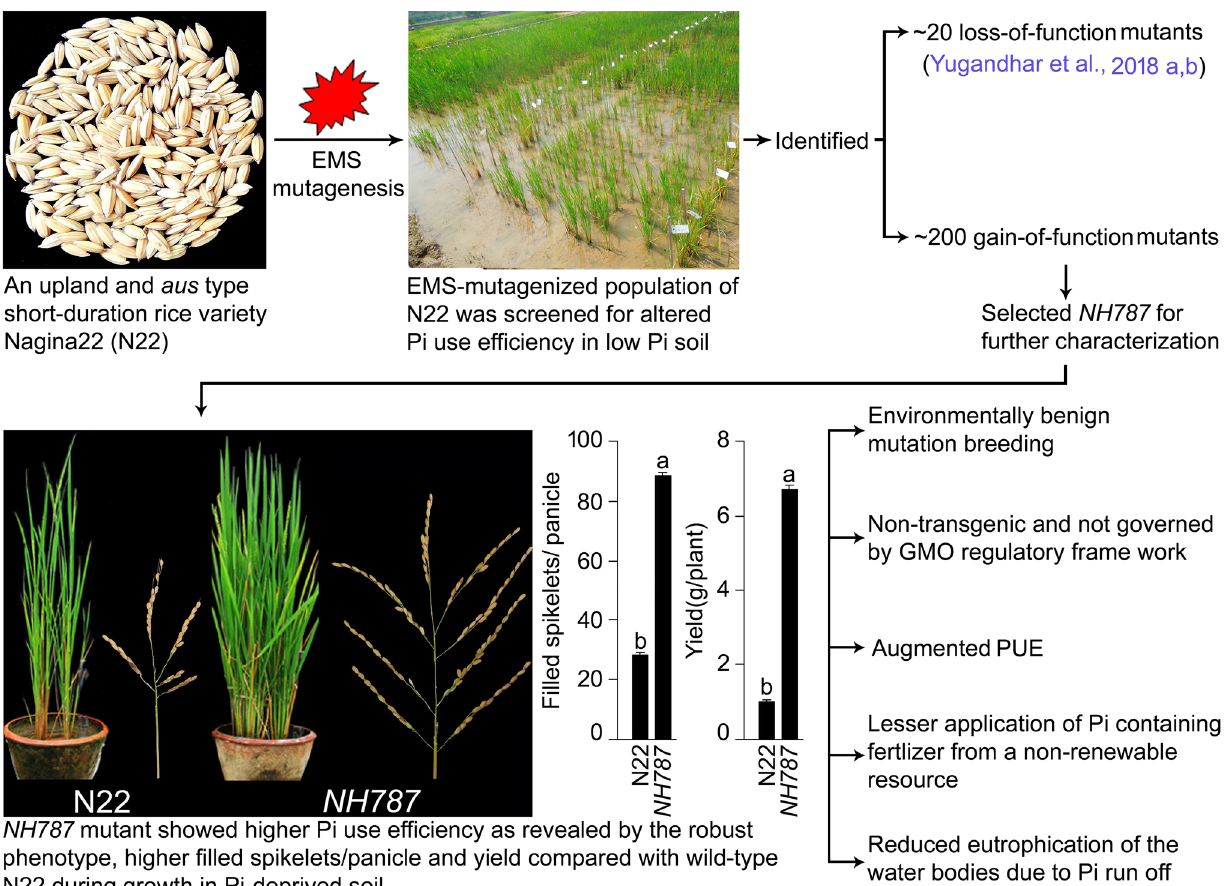
Figure 10. A schematic representation highlighting the efficacy of the EMS mutants for screening the rice variety NH787 with higher PUE in an environment-friendly manner for sustainable